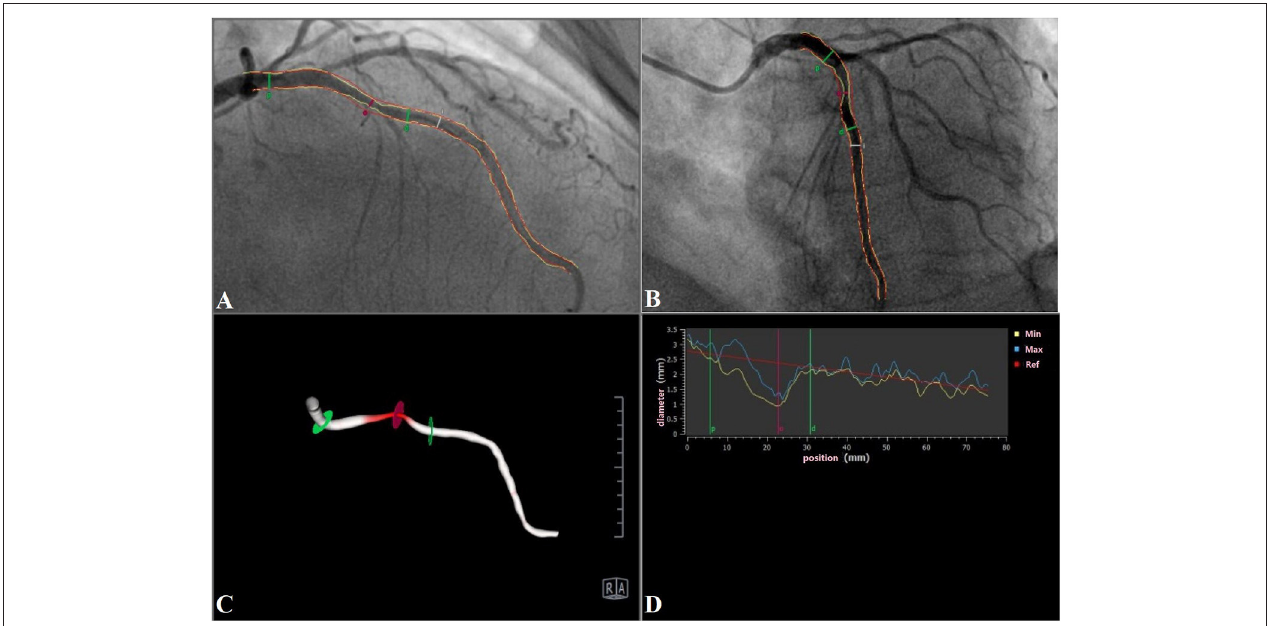
FIGURE 1 | A representative case of LAD (cQFR = 0.71). (A,B) Two-dimensional images; (C) three-dimensional reconstruction (right anterior oblique 50 ◦ , caudal 9 ◦ ); (D) diameter diagram. LAD, left anterior descending artery; cQFR, contrast-flow quantitative flow